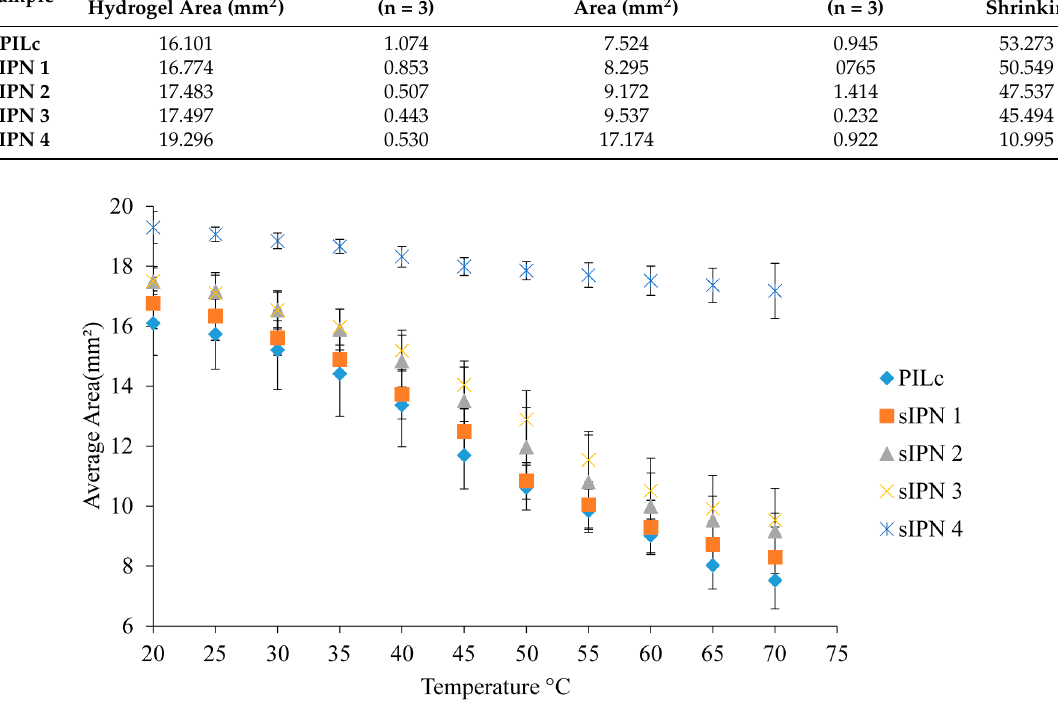
Figure 11. Graphical representation of the temperature induced shrinking profiles of the hydrogels.